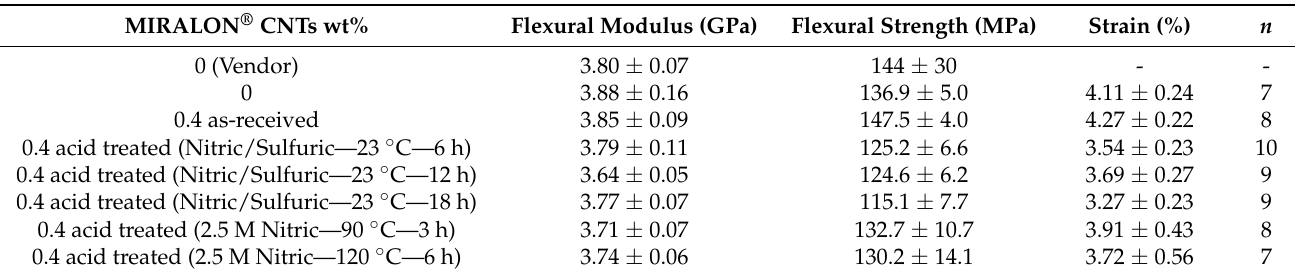
Table 2. Flexural properties ( µ ± δ ) of compression molded epoxy, 0.4 wt% as-received CNT/epoxy, and acid treated 0.4 wt% CNT/epoxy composites.